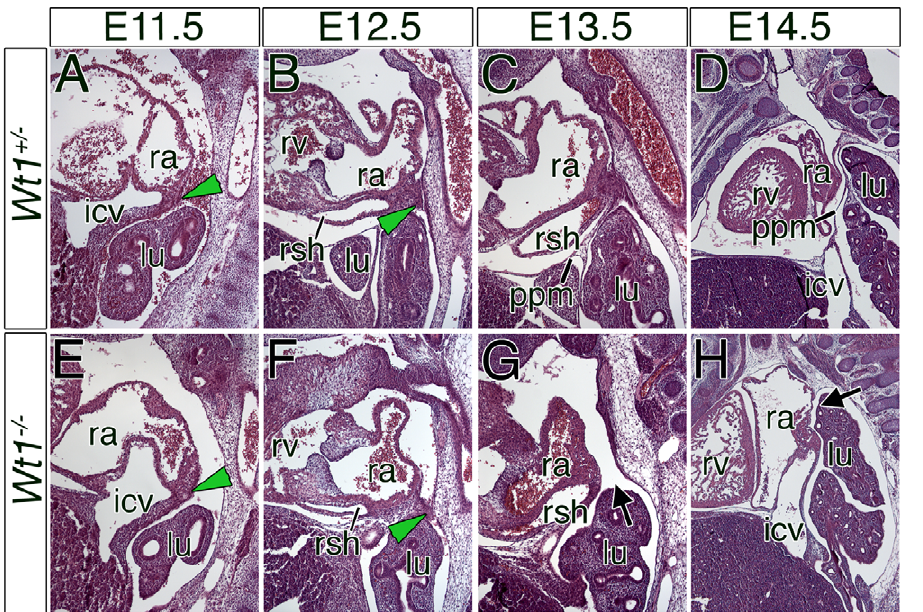
Figure 5. PPC closure is disturbed in Wt1 -deficient embryos. (A–H) Histological analysis by haematoxylin and eosin stainings on sagittal sections through the PPCs of control (genotype: Wt1 + / 2 ) and Wt1 -mutant embryos from E11.5 to E14.5. Black arrows highlight the pericardial defect in Wt1 -deficient embryos at E13.5 and E14.5. Green arrowheads mark the mesenchymal ridges in control and Wt1-deficient embryos at E11.5 and E12.5. Stages and genotypes are as indicated. icv, inferior cardinal vein; lu, lung; ppm, pleuropericardial membrane; ra, right atrium; rsh, right sinus horn; rv; right ventricle.